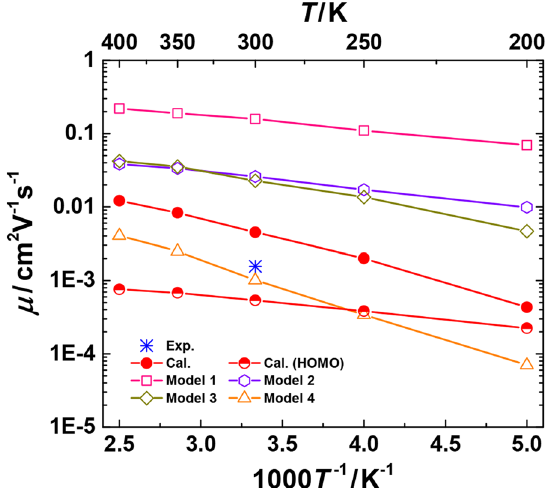
Fig. 5 Kinetic Monte Carlo simulations of the temperature- dependent hole mobilities. These are calculated for: (i) the spiro- OMeTAD crystal by using the full set of parameters (Cal.) and by considering only the HOMO channel [Cal. (HOMO)], as well as (ii) four model systems in which homogeneous transfer integrals (Model 1), the absence of intermolecular electronic polarization effect (Model 2), smaller intramolecular reorganization energy (Model 3), and a model crystal with R = diphenylamine (Model 4) were considered, respectively. For comparison, the experimental hole mobility at room temperature (Exp.) 17 is also